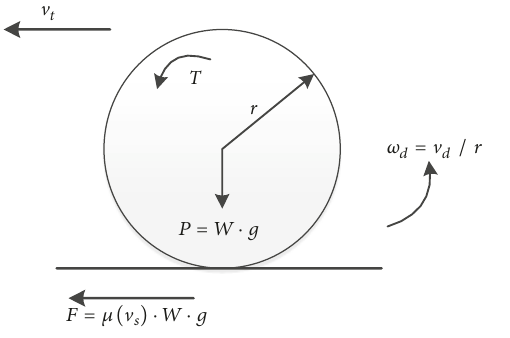
Figure 1: Schematic of adhesion.